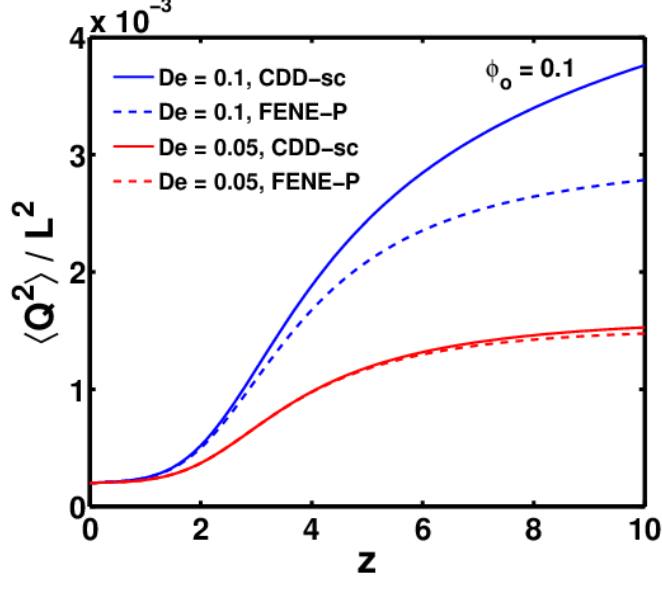
Figure 7. Variation of elastic stresses (ES) and Wi + predictions for FENE-P and CDD-sc models, as the jet thins from nozzle tip up to z max , for φ 0 = 0.1 at two different De numbers. This is directly related to changes in the conformation of the polymer molecules, which can be measured using the ratio (cid:104) Q 2 (cid:105) / L 2 , whose maximum value is 1, representing a completely stretched polymer molecule. Changes in the drag coefficient become significant only when the polymer molecules are sufficiently stretched. The relation between the two is explained in more detail in Figure 8, which shows the plot of (cid:104) Q 2 (cid:105) / L 2 as a function of z for the same parameters used in Figure 7.